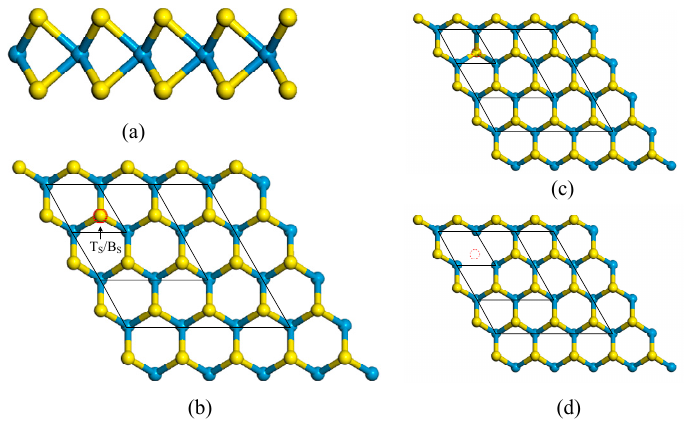
Figure 1. Schematic structure of pure 5 × 5 × 1 monolayer WS 2 : ( a ) side view; ( b ) top view; and supercell models of the defective monolayer WS 2 : ( c ) V S and ( d ) V 2S . T S represents the S atom on the top site, and Bs represents the S atom on the bottom site. The red solid circle represents the doping position of O atom in 2 × 2 × 1, 3 × 3 × 1, 4 × 4 × 1 and 5 × 5 × 1 WS 2 supercell in ( b ). The red dotted circles given in ( c , d ) represent the positions of the vacancy of 2 × 2 × 1, 3 × 3 × 1, 4 × 4 × 1 and 5 × 5 × 1 WS 2 supercell. The yellow and blue balls represent S and W atoms, respectively. In ( b – d ), the black solid lines represent the computational model of 2 × 2 × 1, 3 × 3 × 1, and 4 × 4 × 1 WS 2 supercell.